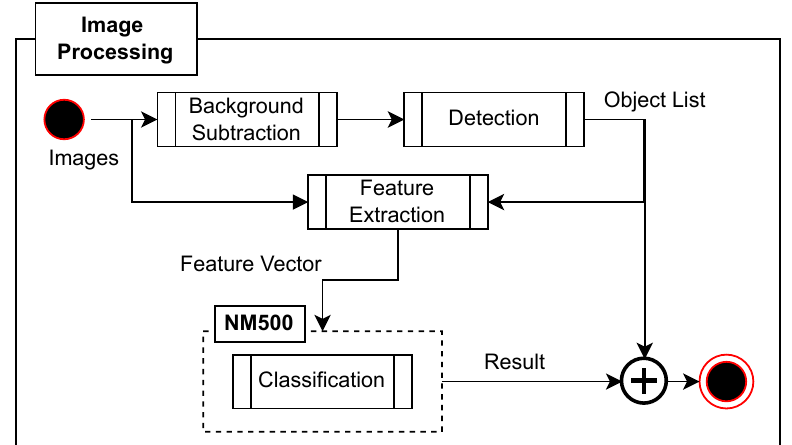
Figure 5. Data processing implemented with